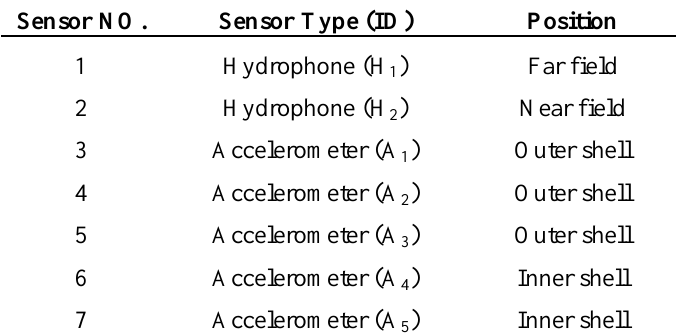
Table 2. Description of sensors.